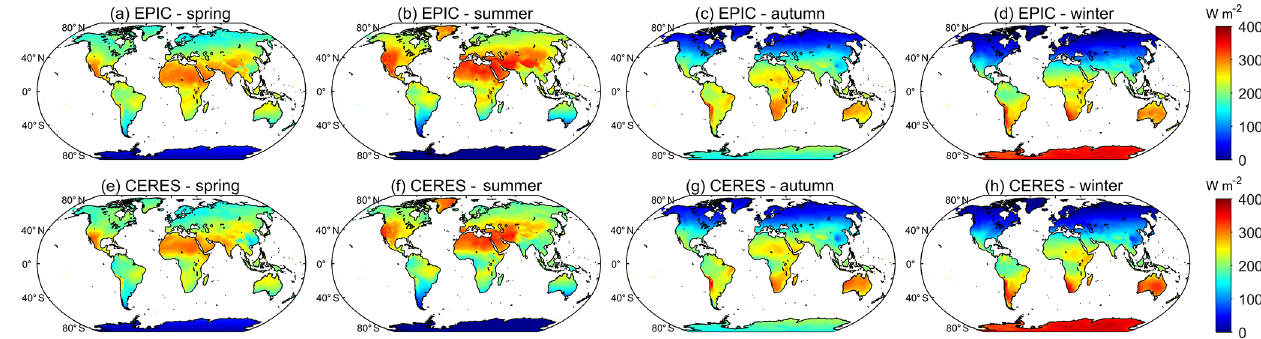
Figure 9. Global distributions of EPIC- and CERES-derived total SW fluxes for different seasons during the study period, 2016–2018.